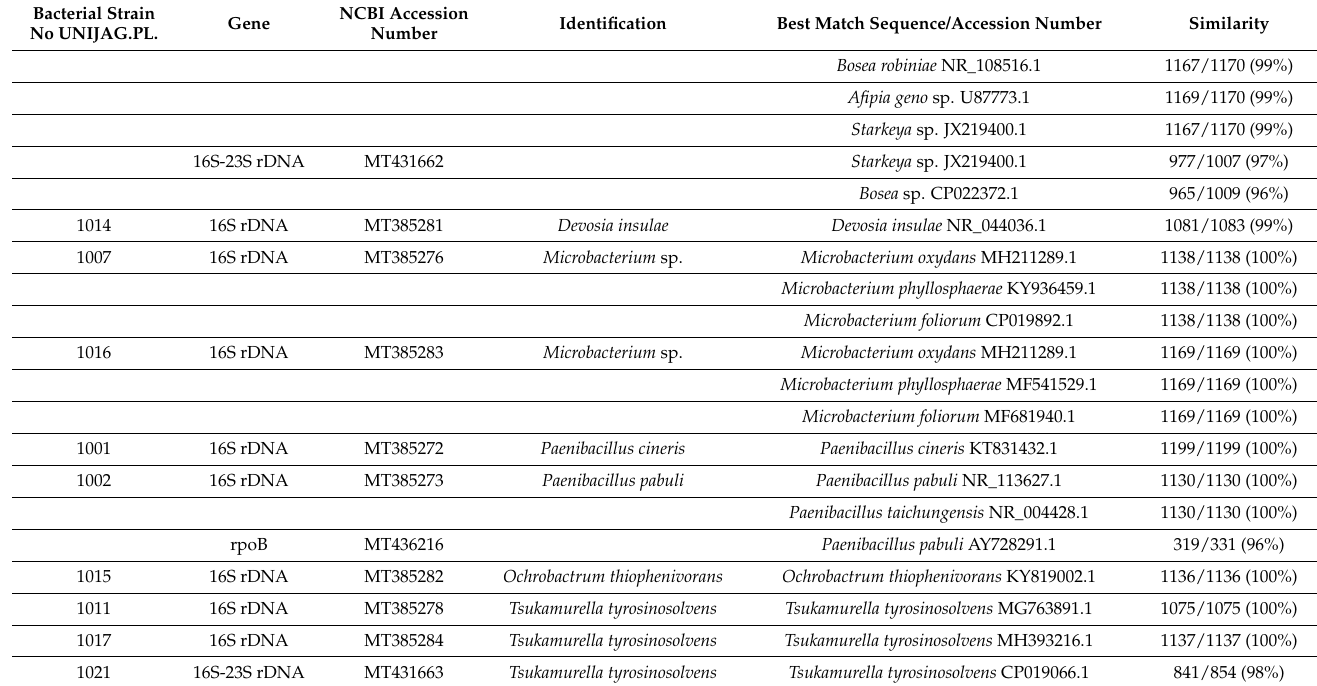
Bacterial Strain No